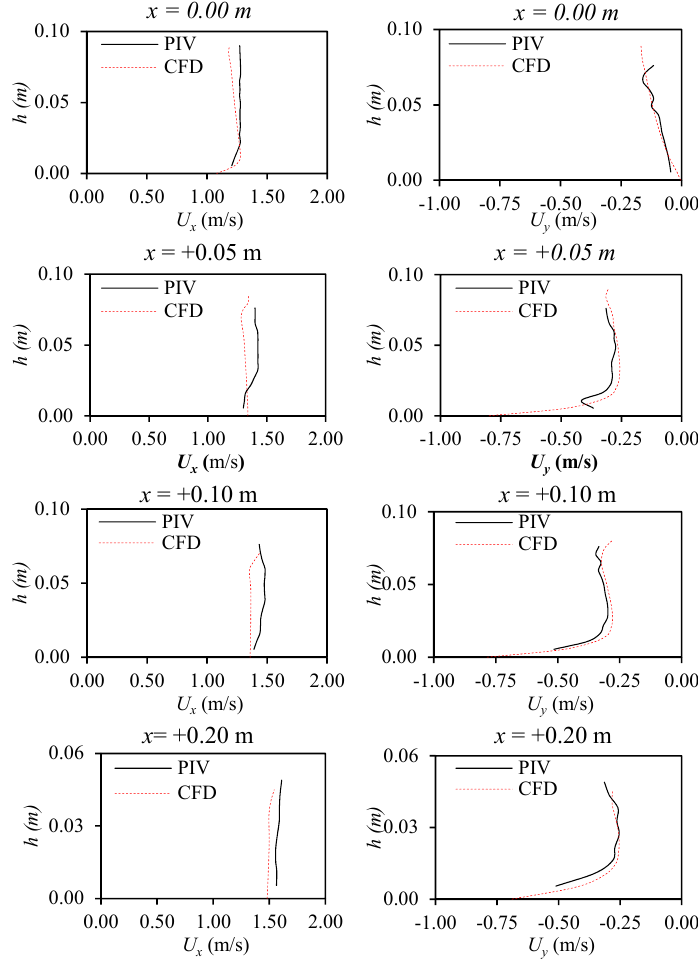
Figure 10. Longitudinal and perpendicular components of the velocity, U x ( left ) and U y ( right ) calculated with PIV and simulated with CFD.